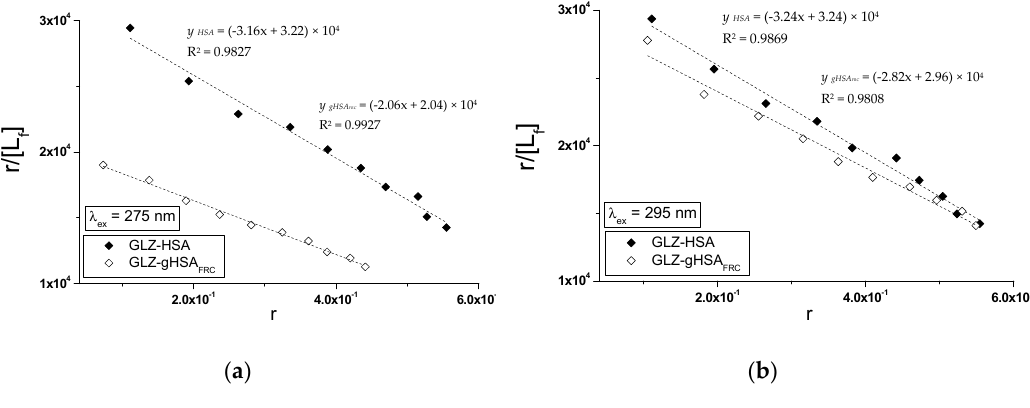
Figure 8. The Scatchard curves for GLZ-HSA and GLZ-gHSA FRC . ( a ) λ ex = 275 nm and ( b ) λ ex = 295 nm; the error bars are smaller than the symbols.